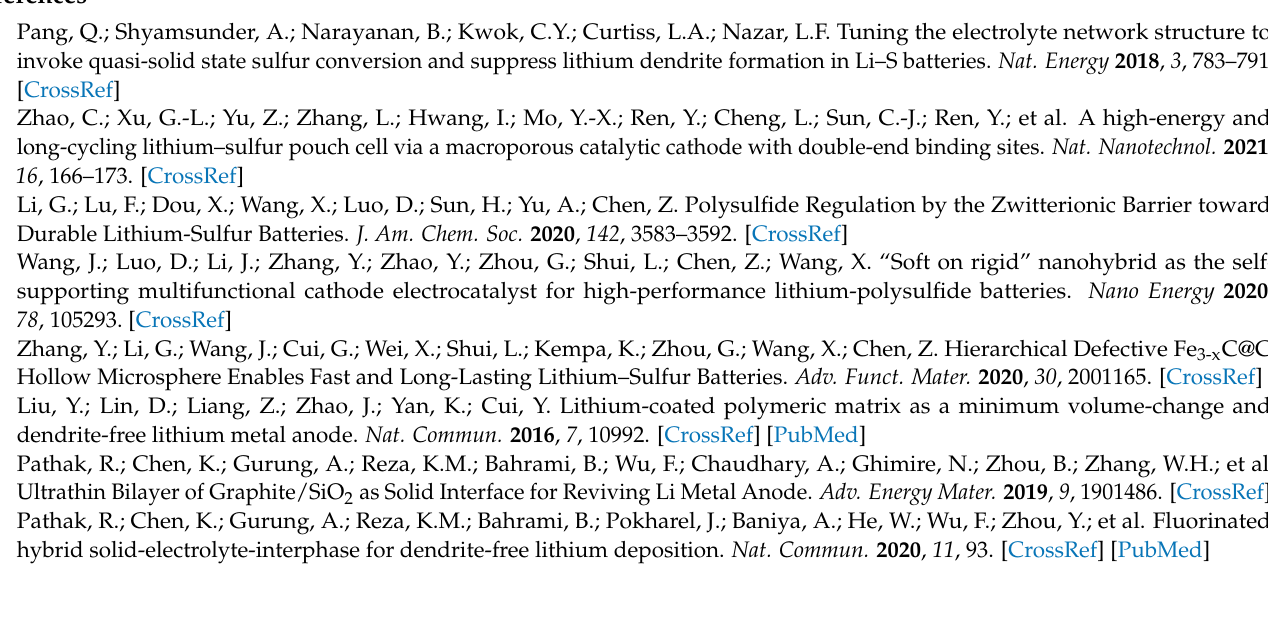
loading, Table S1: Conductivities of Nb4N5, Nb2O5/Nb4N5 and Nb2O5, Table S2: The resistance of Rs and Rct simulated from equivalent circuits, Table S3: Pore size distribution and/or pore volume of Nb4N5, Nb2O5/Nb4N5 and Nb2O5, Table S4: Comparation of electrochemical properties of our work with other